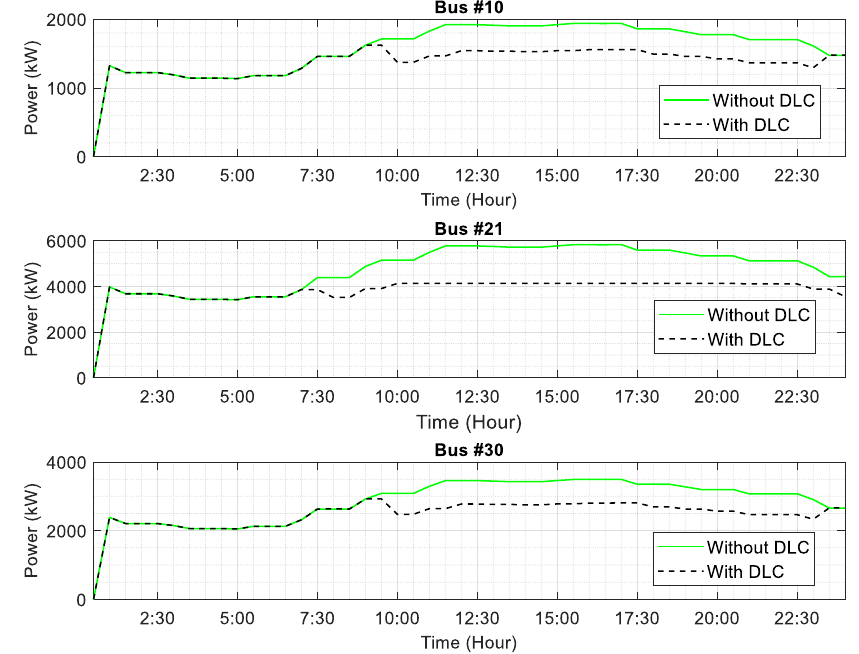
Figure 14. Case VI: Power vs. time with / without DLC in the presence of DG.